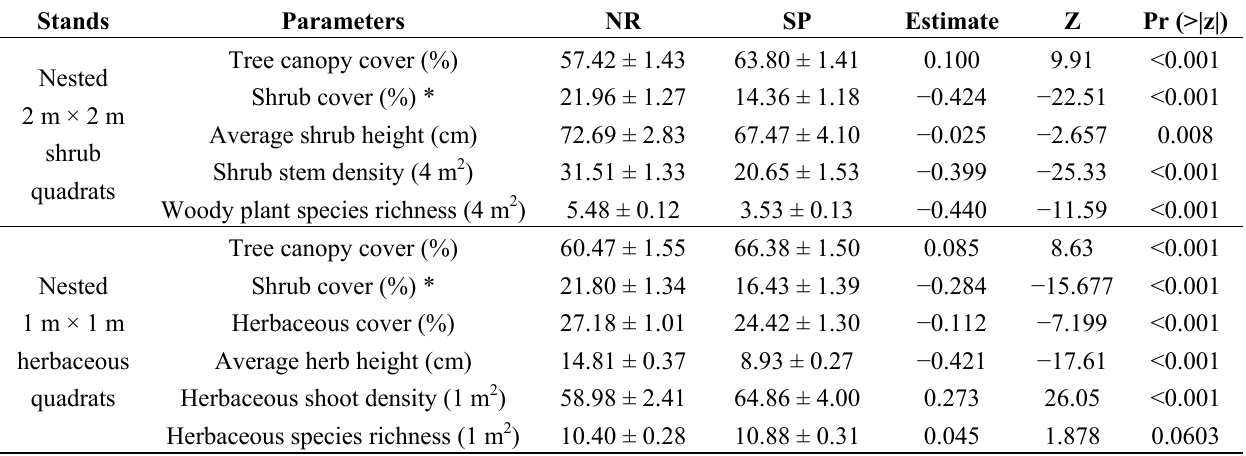
Table 1. Structure and species density (mean ± SE) in shrub and herb layers from the naturally regenerated forests (NR) and the reforested spruce forests (SP) originating from similar clear-cuts in the eastern Tibetan Plateau. The difference between the NR and the SP was tested by generalized linear mixed-effects models (GLMMs). Treatment (NR vs. SP) was introduced as a fixed factor and stands (12 vs. 12) as a random factor, with three plots nested in each stand, and nine quadrats nested in each plot. In each case, Poisson error distribution with log-link function was selected in GLMMs. * indicated that shrub included shrub and tree